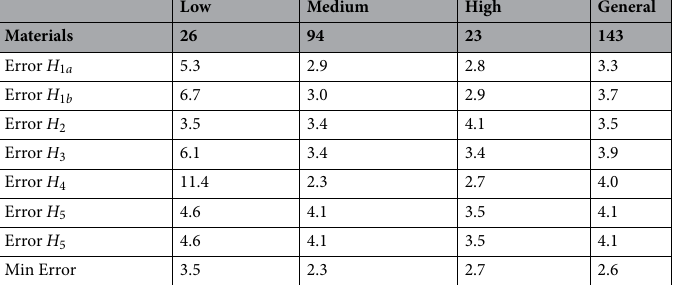
Table 3. Hardness MAE (GPa) for various materials classified by density (High, Medium and Low), using six different semi-empirical relations. Materials specifies the number of compounds considered in each classification. The Min Error value corresponds to the method that minimizes the error in each